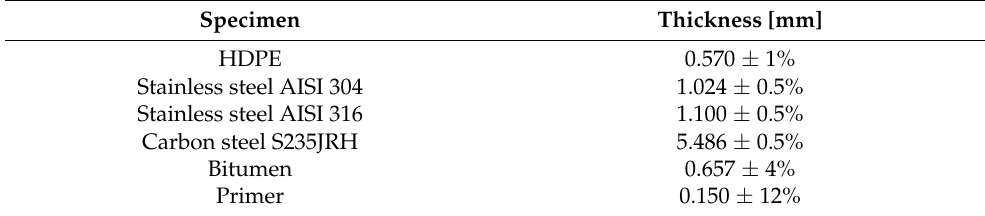
Table 2. Thickness of the specimens: pipe materials and coatings.